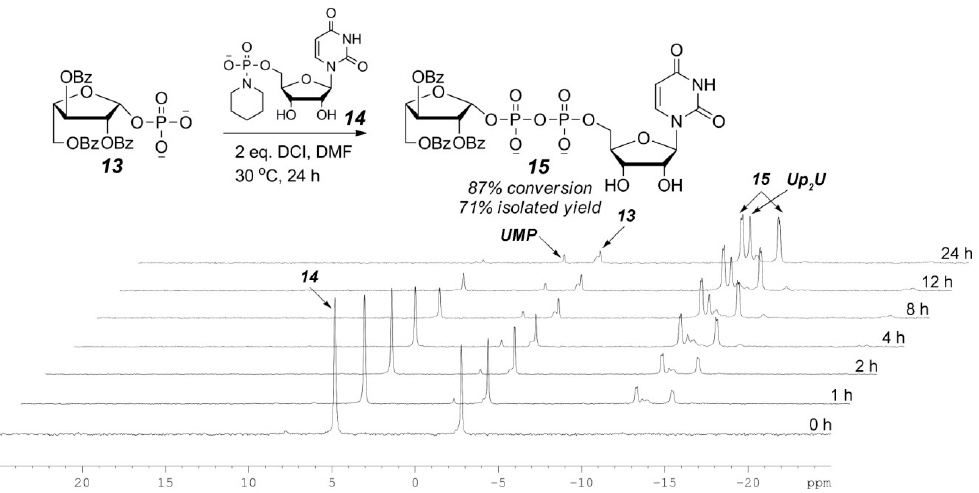
Figure 1. 31 P NMR tracing of the P(V)-N activation coupling reaction of 13 and 14 .